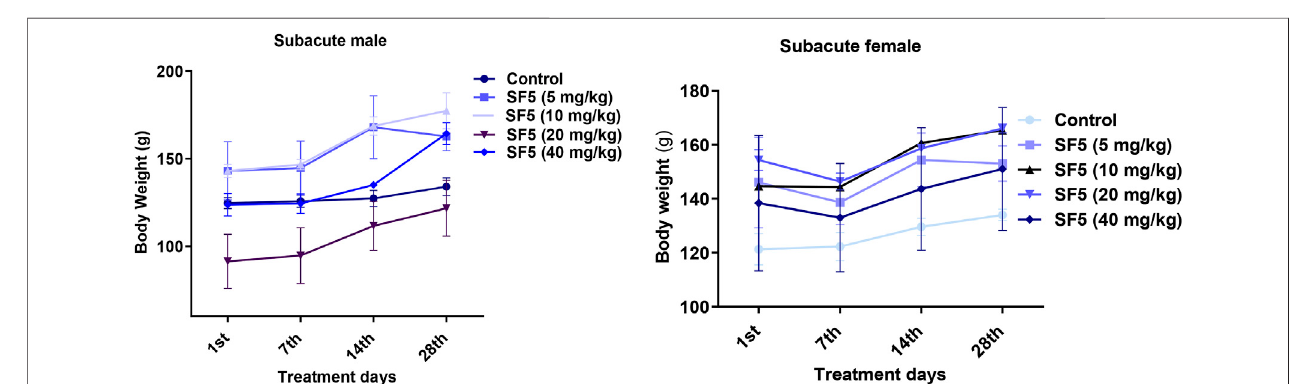
FIGURE 4 | Effect of SF5 on body weights of rats in the subacute toxicity study.